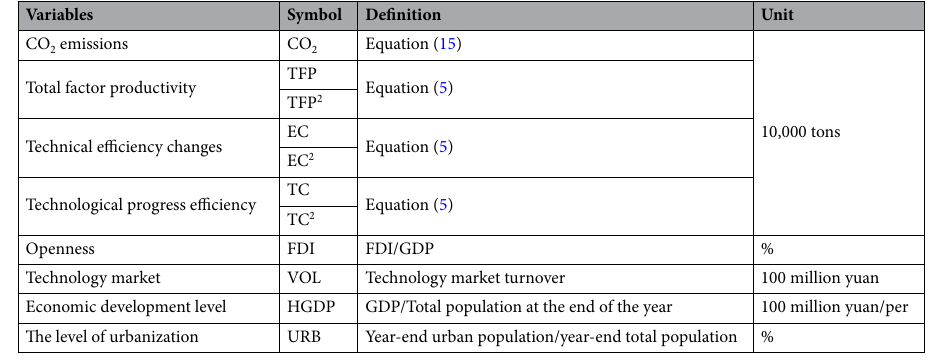
Table 2. Calculation